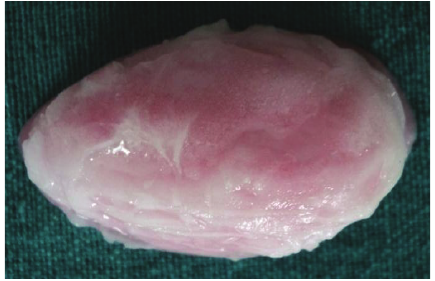
Figure 16: Bulb with soft